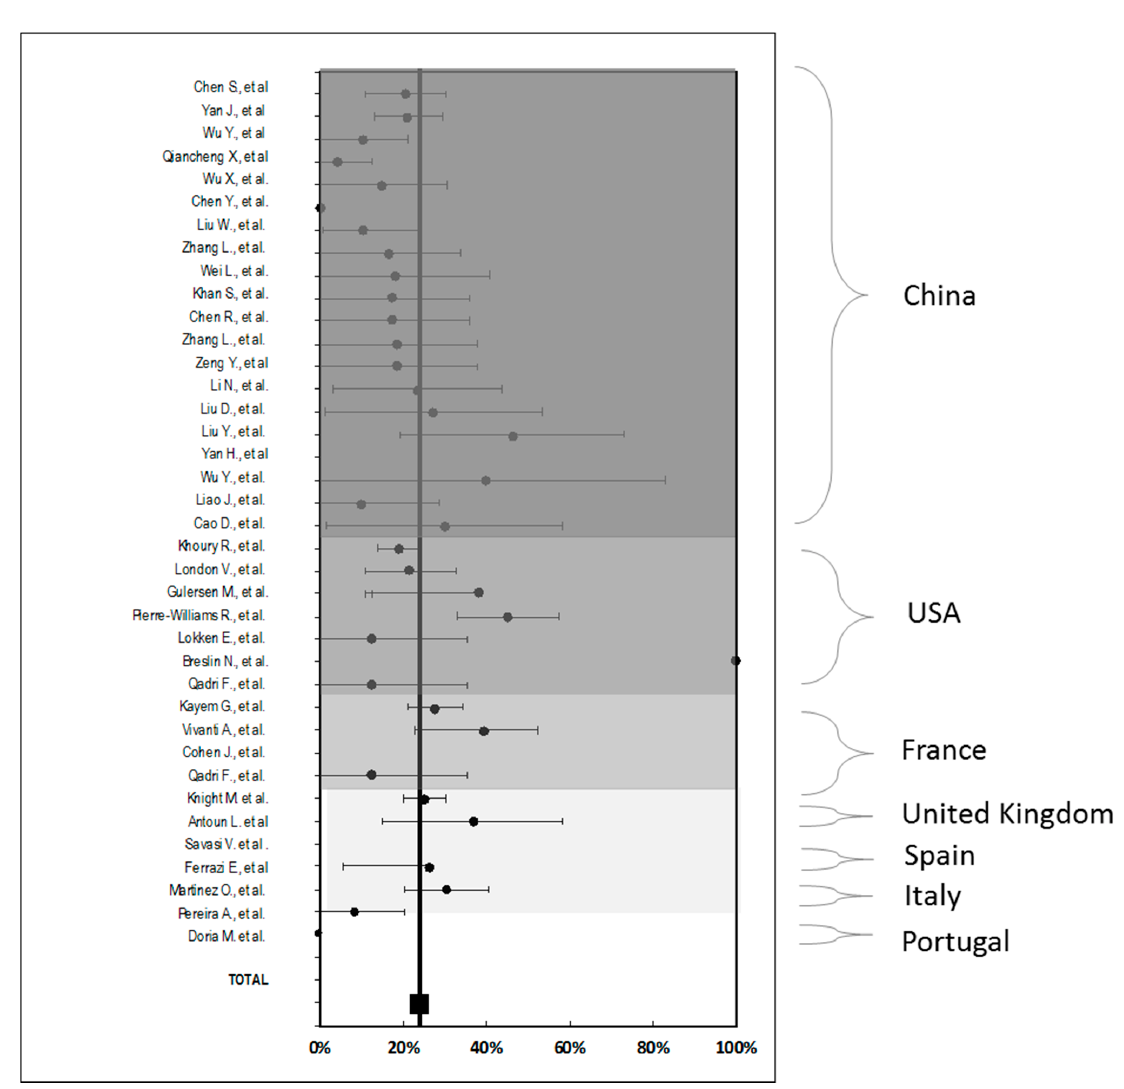
Figure 3. Percentage of prematurity, with 95% confidence interval observed in the studies and grouped by country. Works published from the USA described a patient with the highest BMI levels (31.8 kg/m 2 ) as well as maternal comorbidities (32.6%). In this country, median GA at triage (31.5 weeks) and the average percentage of patients with symptoms at the triage (60.8%) was the lowest of the registered in this systematic review. After China, it reported the highest rate of patients with urgency of maternal oxygen therapy (38.4%) and NICU admission to newborns